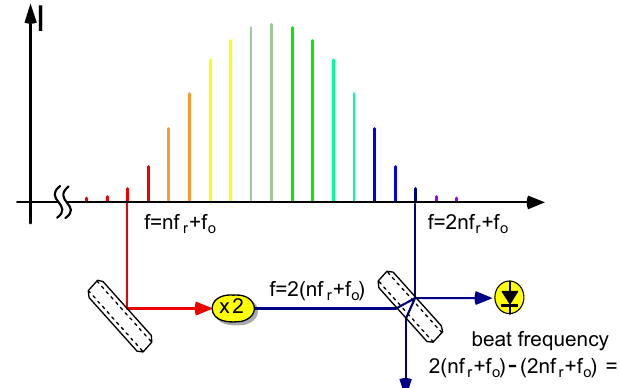
Fig. 2. The offset frequency is found by taking the difference of the frequencies of a comb mode at f n and the second harmonic of the mode at f 2 n .